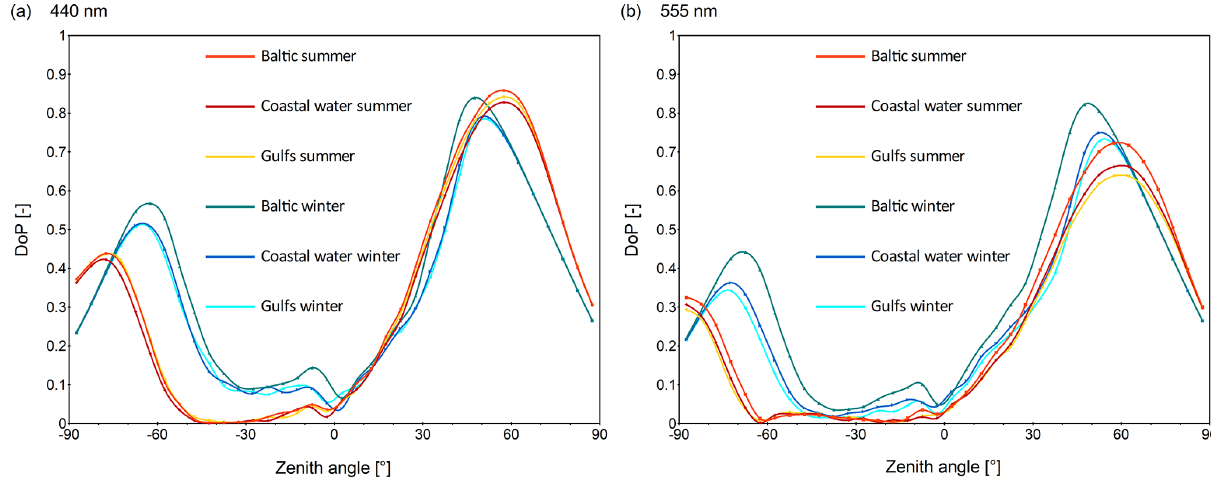
Figure 6. Degree of polarization plotted for the principal plane, i.e., plane containing both incident ray of the Sun and zenith direction (cross-section through polar plots for azimuths 0 and 180 ◦ ). Azimuth of 0 ◦ is marked by negative zenith angles. Simulation results are for wind speed of 5ms − 1 for all types of water and two seasons: (a) 440 and (b) 555nm.